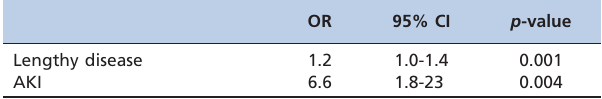
Table 3 - Independent risk factors for thrombocytopenia in patients with leptospirosis at admission. Table 4 - Independent risk factors for thrombocytopenia in patients with leptospirosis during their hospital